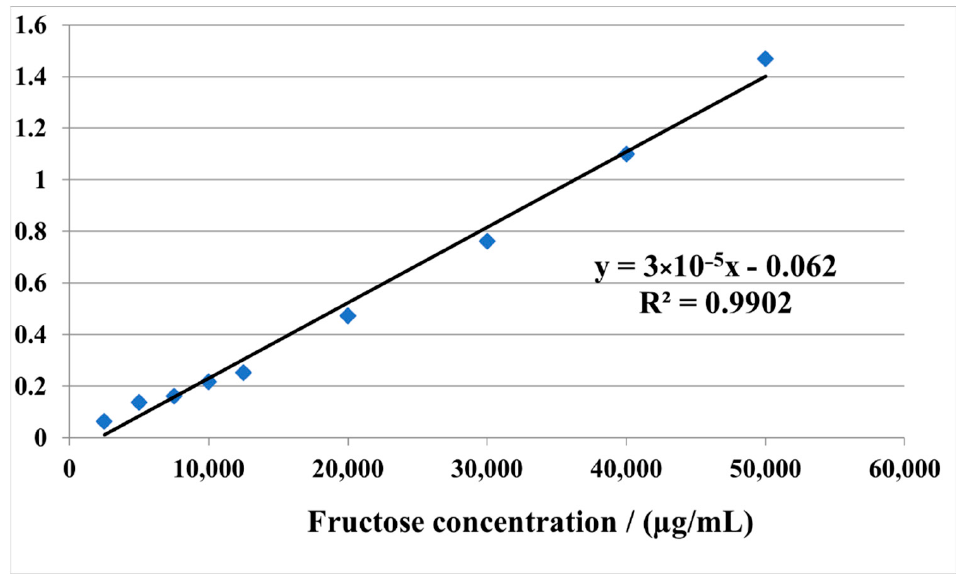
Figure 2. The calibration curve for dosing of